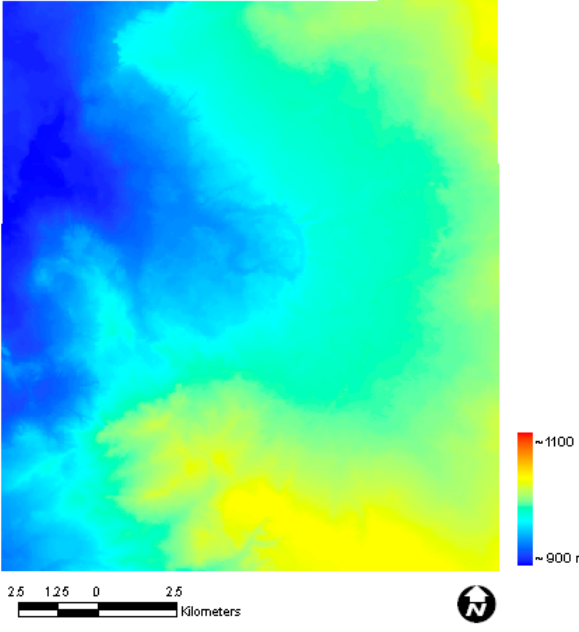
Figure 3. Digital Elevation Model (DEM) for the study site.